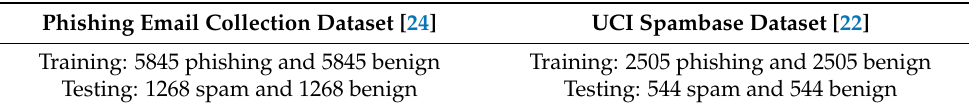
Table 6. Training and testing datasets.